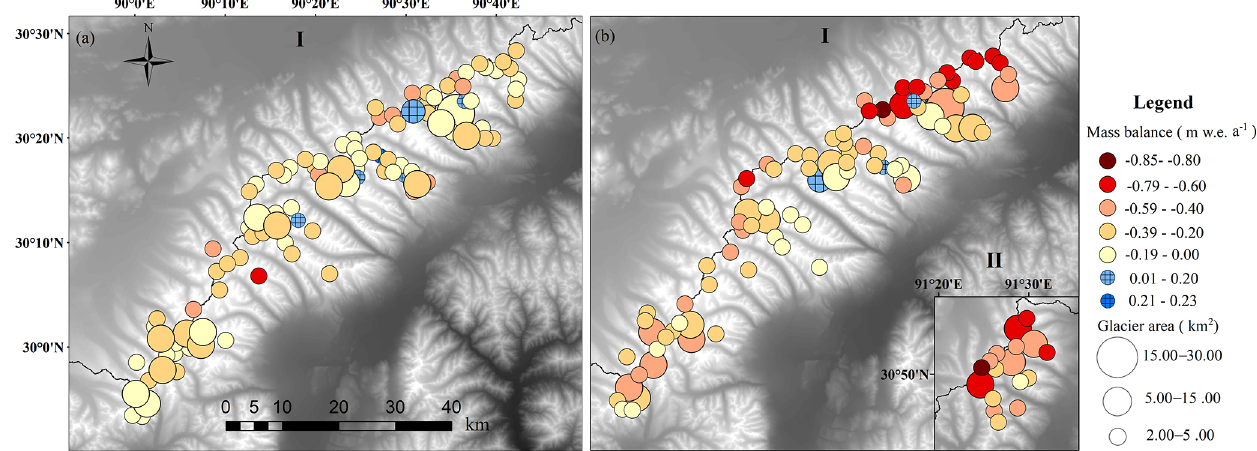
Figure 7. The distribution of glacier-wide mass balance for individual glaciers ( > 2km 2 ) in the WNR from (a) 1976 to 2000 and (b) from 2000 to 2020. Label I represents the SW section, and label II represents the NE section of the WNR (on the same map scale).